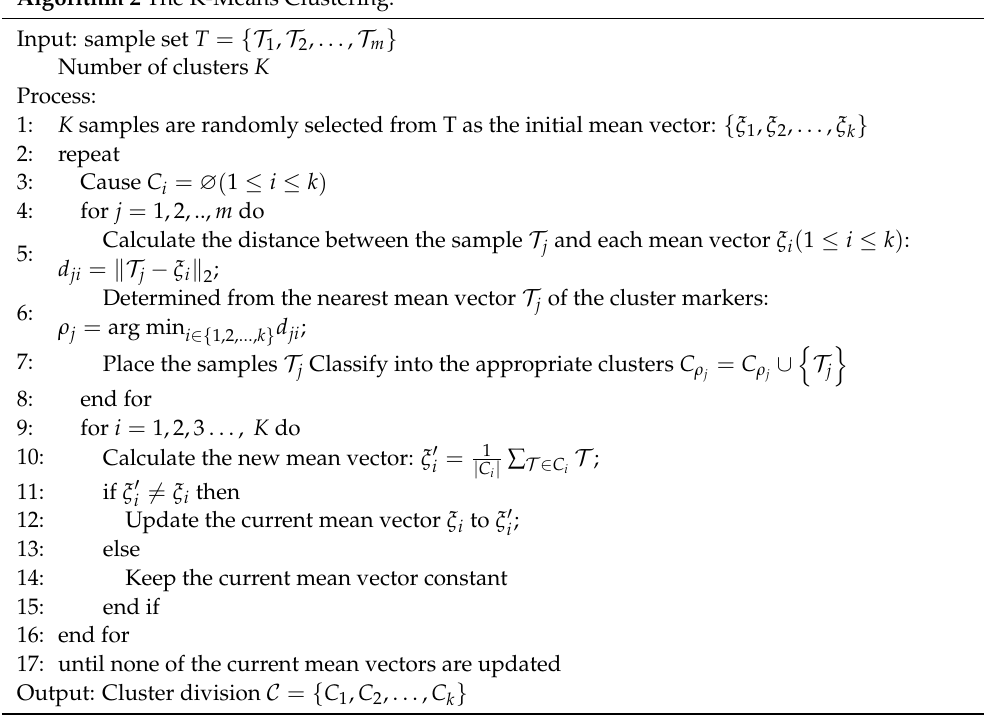
Algorithm 2 The K-Means Clustering.